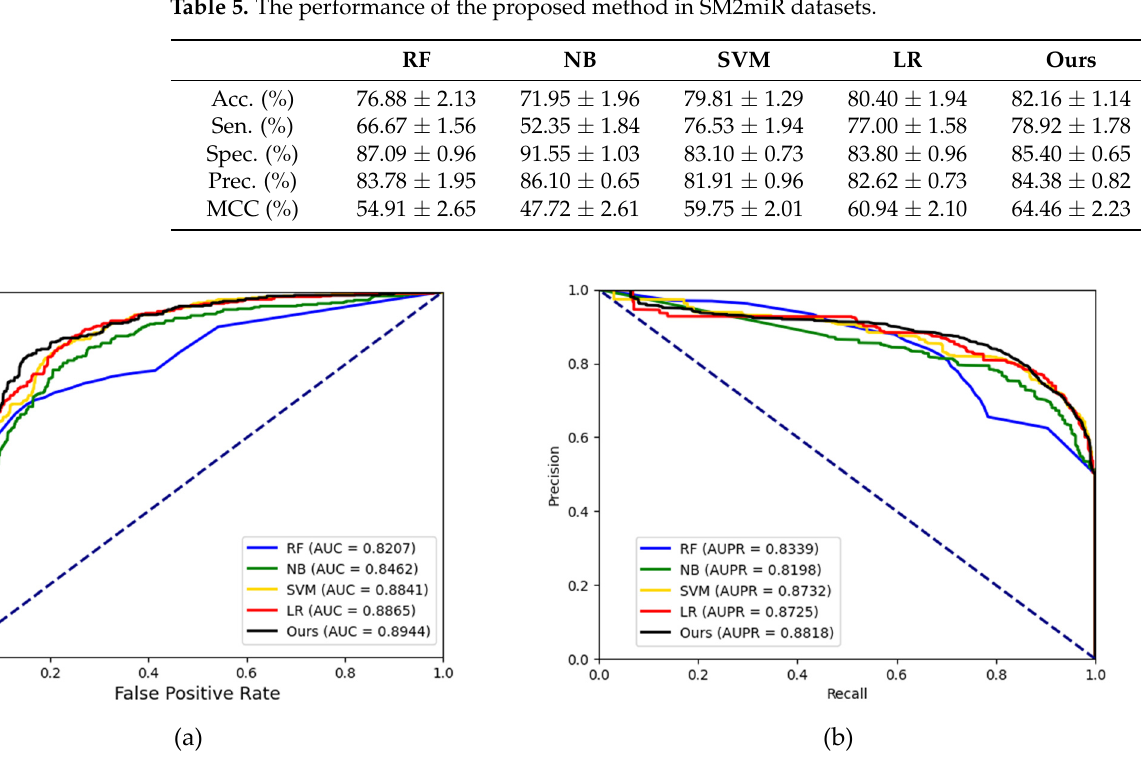
Figure 10. Result of ablation experiment on the ncDR dataset.